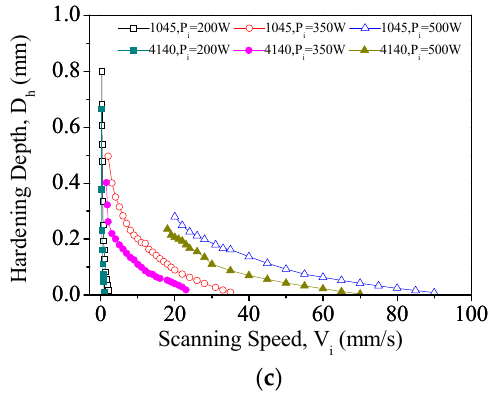
Figure 13. ( a ) Relationship between scanning speed and temperature during single-track laser heat treatment; ( b ) relationship between scanning speed and hardening width during single-track laser heat treatment; and ( c ) relationship between scanning speed and hardening depth during single-track laser heat treatment.